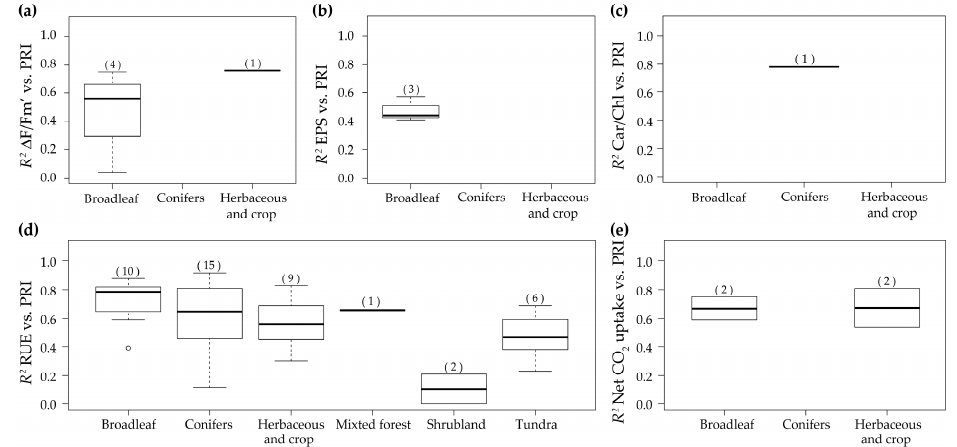
Figure 7. Boxplots of the coefficients of determination of the relationships between PRI and physiological variables at the canopy level and seasonal timescale: ( a ) Actual photochemical efficiency ( Δ F/Fm’); ( b ) Epoxidation state of xanthophylls (EPS); ( c ) Carotenoid/chlorophyll ratio (Car/Chl); ( d ) Radiation-use efficiency (RUE); and ( e ) Net CO 2 uptake. Central lines represent medians, boxes represent 50% of the data, whiskers represent minima and maxima and circles represent outliers. The numbers of correlations reported in the literature are shown in brackets.